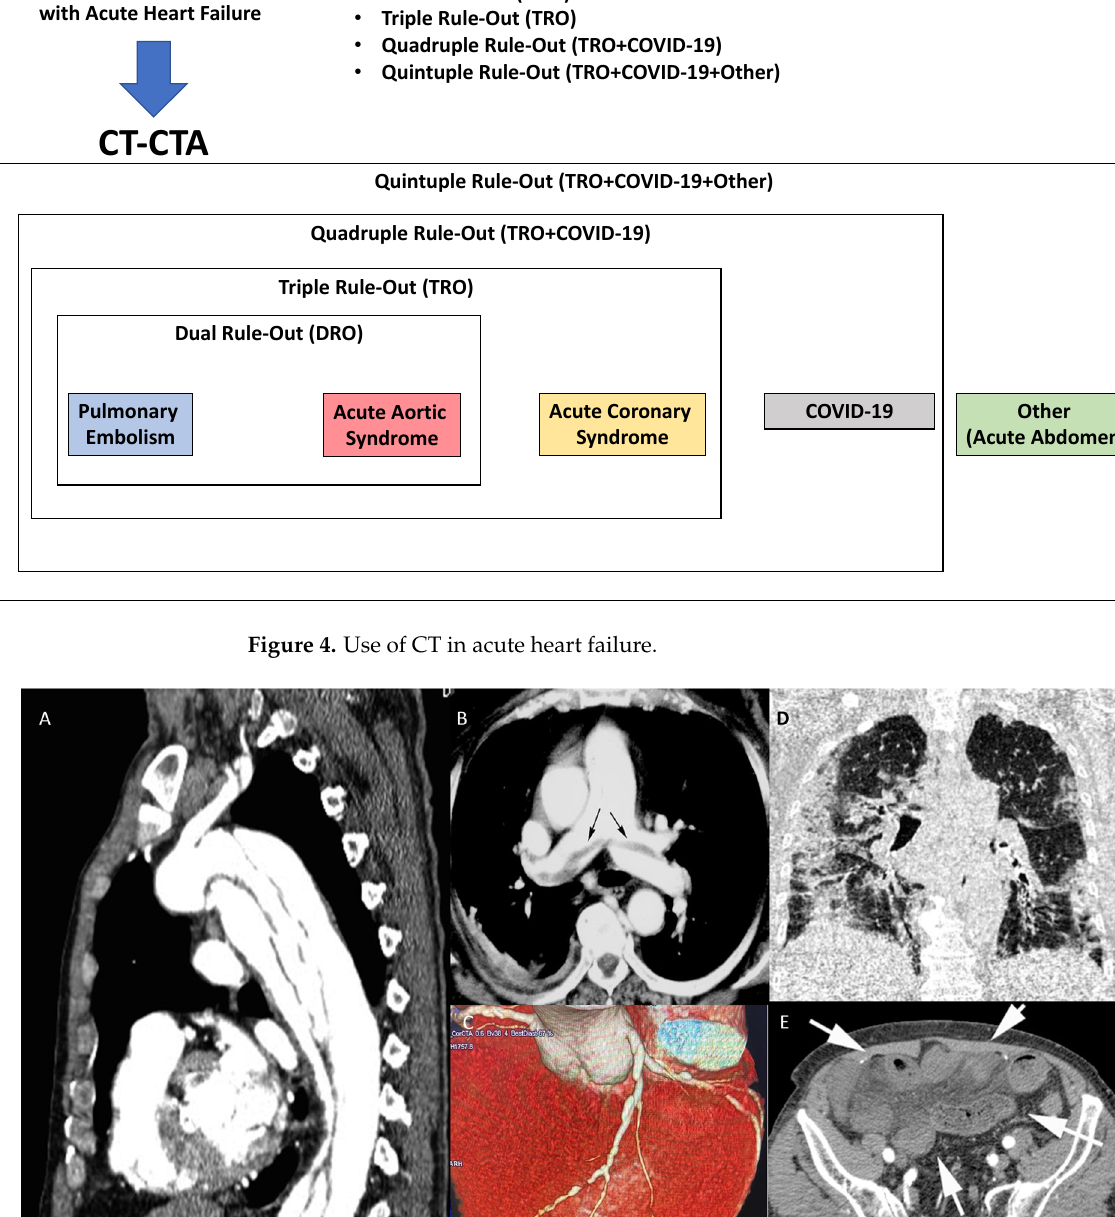
Figure 5. CT in different scenarios. Type B thoracic aortic dissection: post-contrast sagittal CT reconstruction of the aorta demonstrates a medio-intimal flap that begins below left subclavian arterial origin and extends up to diaphragmatic hiatus ( A ). Pulmonary thromboembolism: post-contrast axial CT reconstruction depicts linear contrast defects inside the lumen of main pulmonary arteries (arrows) due to thromboembolism ( B ). Volume rendering post-contrast CT of the left descending coronary artery depicts a brief stenosis of the medium segment ( C ). Coronal unenhanced chest CT shows ground glass opacities of the lungs, especially on the left side, due to interstitial COVID pneumonia ( D ). Post-contrast axial CT image of the pelvis demonstrates ileal loops ischemia with a stratified appearance of the ileal loop’s wall (arrows) due to intramural edema and low submucosal enhancement associated with mesenterial free fluid. ( E